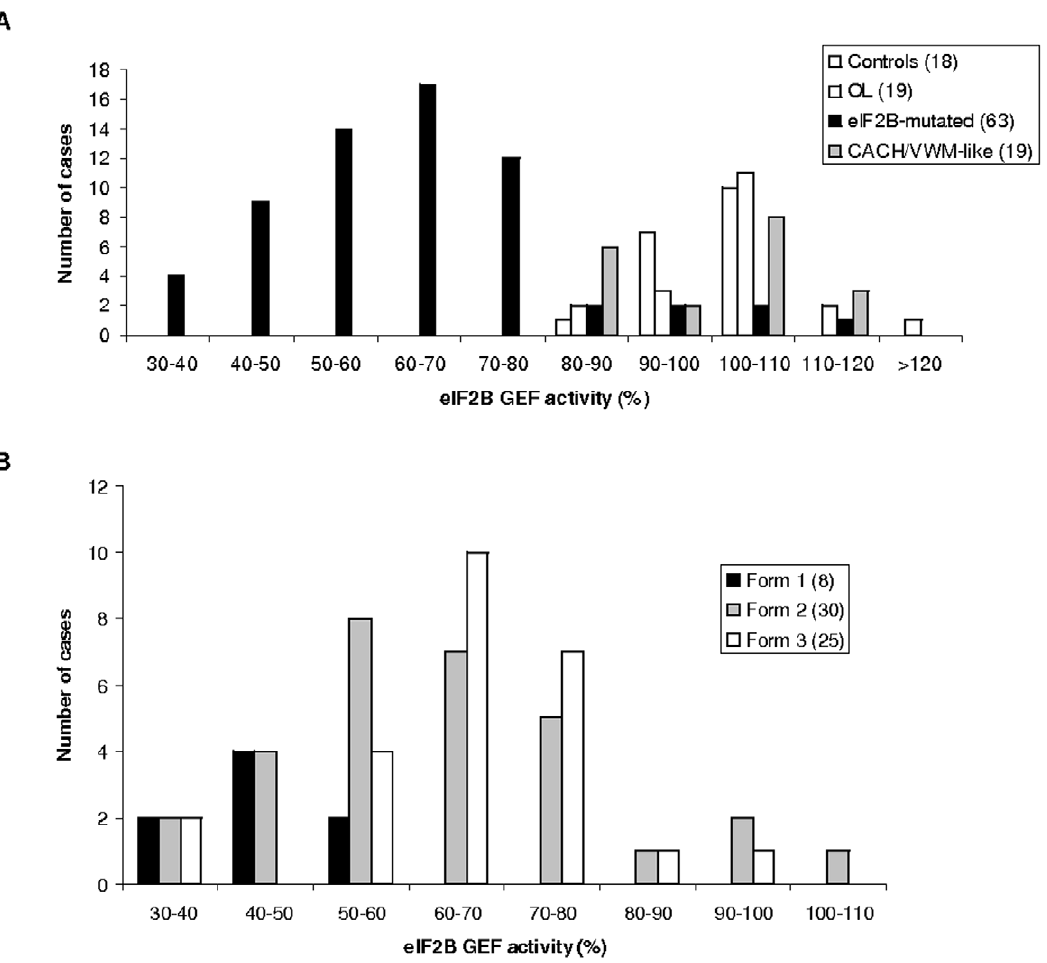
Figure 1. Distribution of patients per classes of eIF2B GEF activity. A . Distribution of the patients’groups per classes of eIF2B GEF activity in %. The patients’ groups are healthy controls, eIF2B-mutated, others leukodystrophies (OL) and CACH-VMW-like. B . Distribution of the 63 eIF2B-mutated patients per classes of eIF2B GEF activity. The mutated patients have been classified into three clinical groups depending of their clinical severity, according to previous studies [5]. Form 1: disease onse before 2 years, form 2: disease onset berween 2 and 5 years, form 3: disease onset . 5 years.